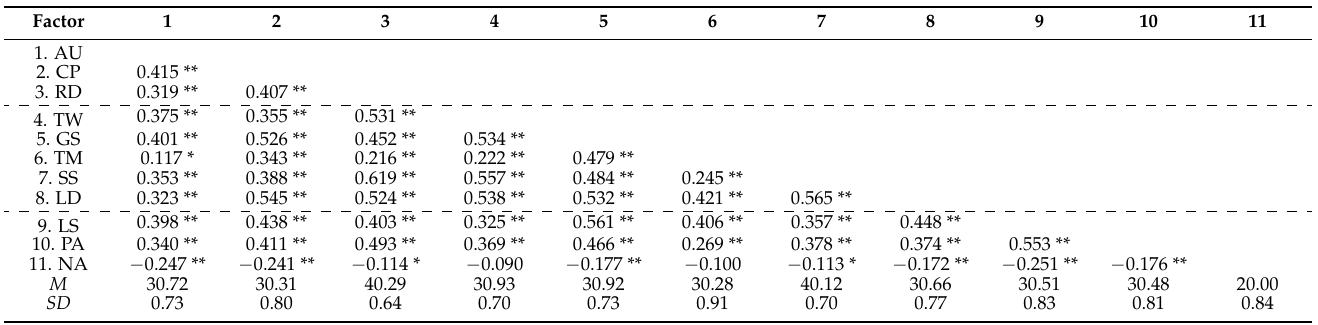
Table 2. Descriptive statistics and